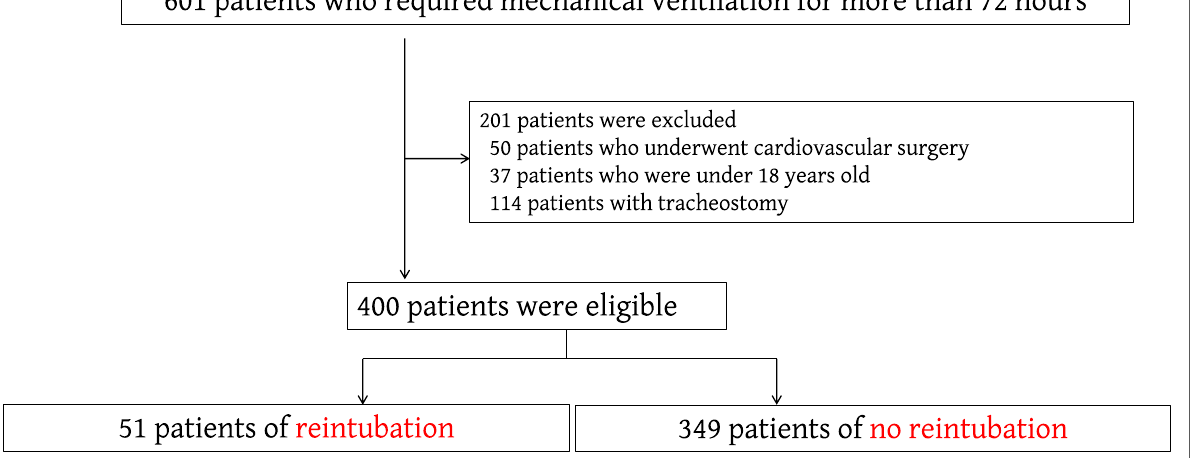
Fig. 1 Flow diagram of this